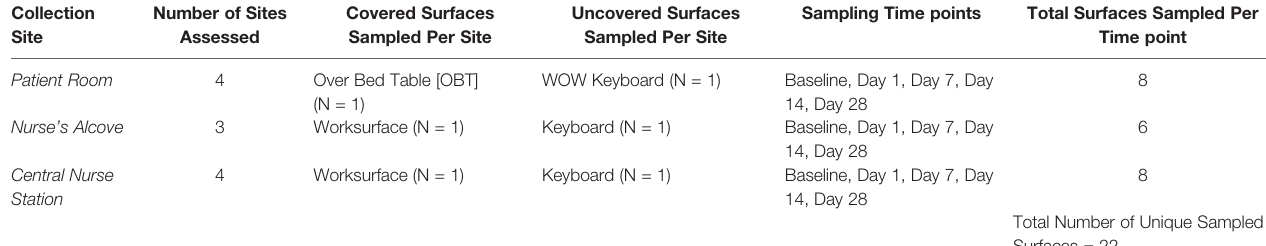
TABLE 1 | Summary of collection sites, surfaces sampled, and sampling time points during the